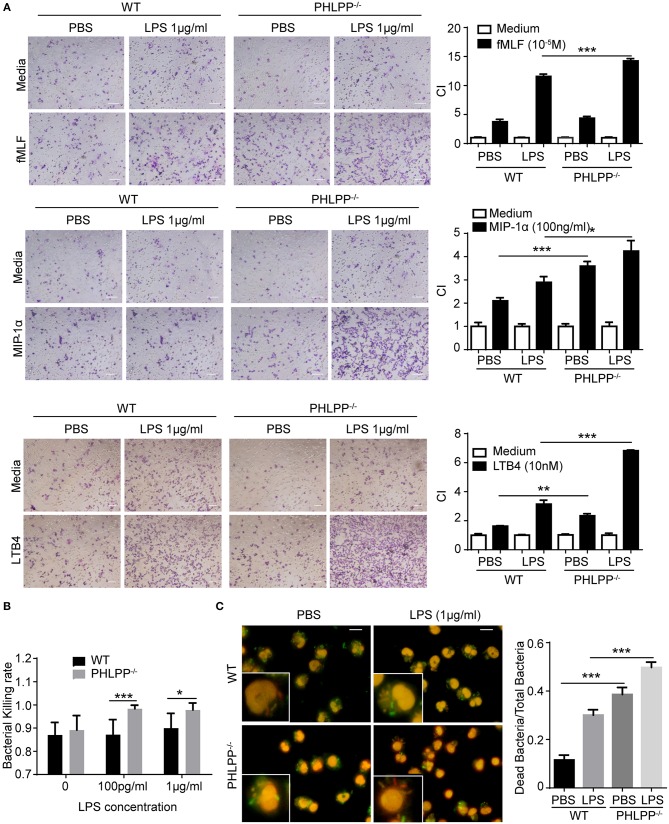
Enhanced neutrophil migratory function as well as elevated bacterial killing activity in vitro due to due to PHLPP deficiency. (A) Chemotaxis of neutrophils from bone marrow to fMLF, MIP-1α, or LTB4. Bone marrow neutrophils were primed with LPS (1 μg/ml) or PBS as control overnight, then subjected to the chemotaxis assay. Macroscopic observations of chemotaxis chamber were grouped on the left, and quantification of migrated neutrophils was shown in bar graph on the right. n = 3 each group. Scale bar = 50 μm. *p < 0.05, **p < 0.01, and ***p < 0.001. (B) Bacterial killing assay through plating. n = 6 each group. (C) Intracellular assay of live and dead bacteria through differential staining. Neutrophils were infected with E.coli, then exposed to the live/dead staining kit with propidium iodide and SYTO9. Live bacteria appeared green, dead bacteria appeared red and nuclei appear pink (left). Bacterial killing ability was analyzed by dead bacterial/total bacterial x100% (right). n = 80 each group. ***p < 0.001.